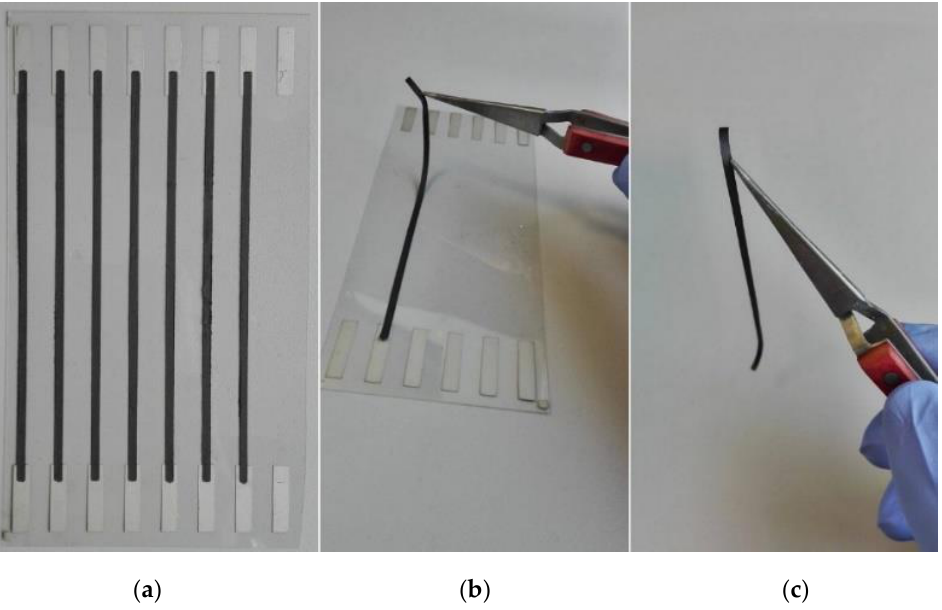
Figure 1. Conductive routes printed with silicone/graphene nanoplatelets composite. ( a ) samples with silver electrical contacts; ( b ) detachment of the sample from substrate; ( c ) standalone conducting route.